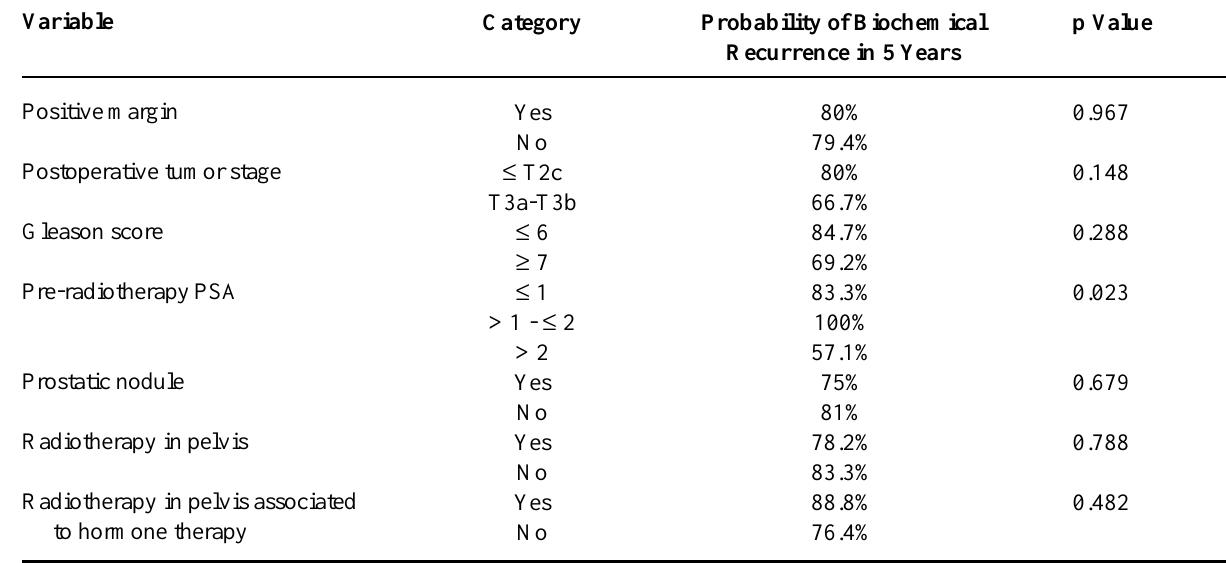
Table 3 – Univariate analysis of variables associated to biochemical recurrence free survival rate in 5 years after salvage conformal radiotherapy.